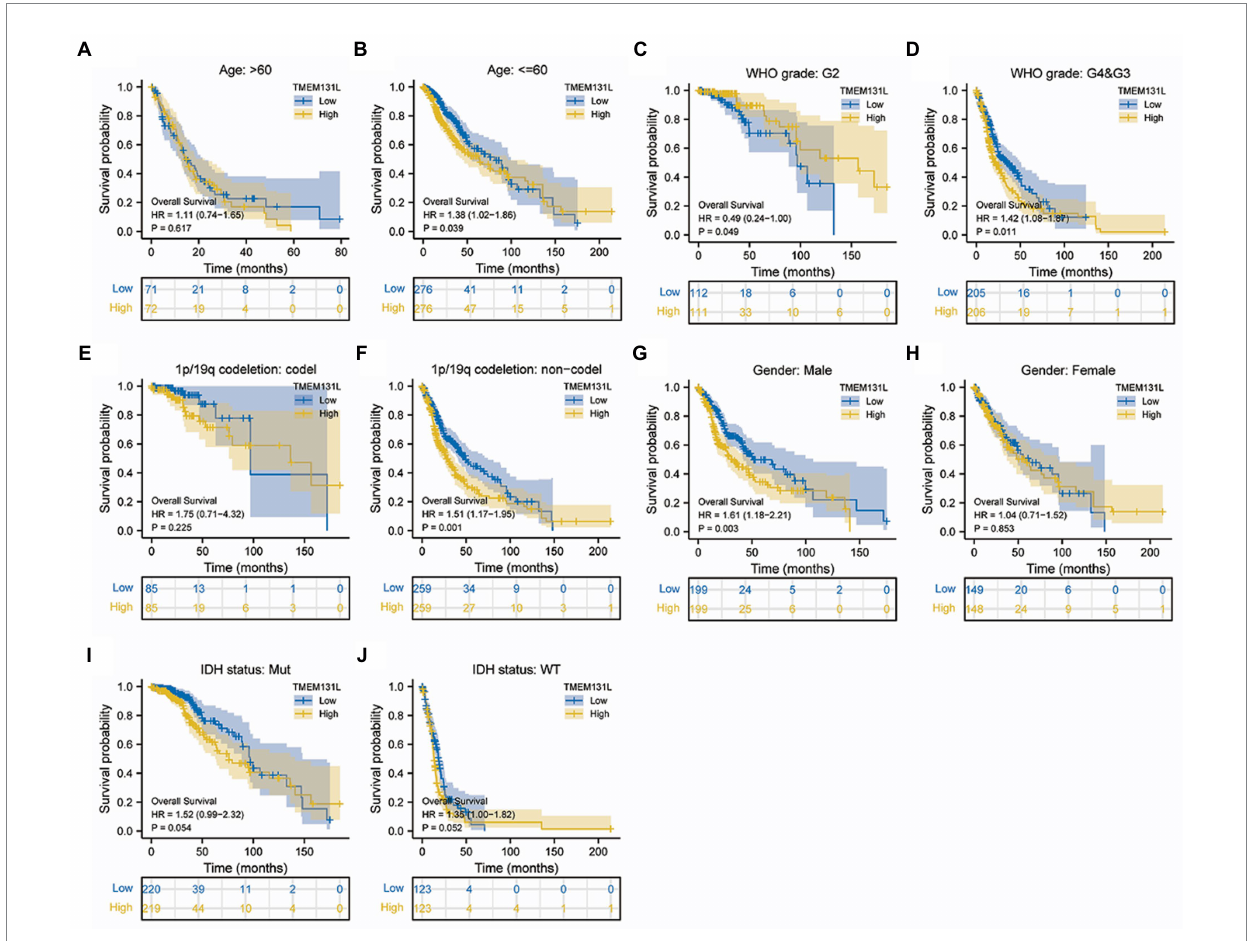
FIGURE 7 In TCGA-GBMLGG, the K-M curve of TMEM131L affected the overall survival of GBM and LGG patients in each pathological subgroup. TMEM131L had an overall survival prognostic significance in age (A,B) , WHO grade (C,D) , 1p/19q codeletion: codel (E,F) , Gender (G,H) , and IDH status (I,J) pathological subgroups,